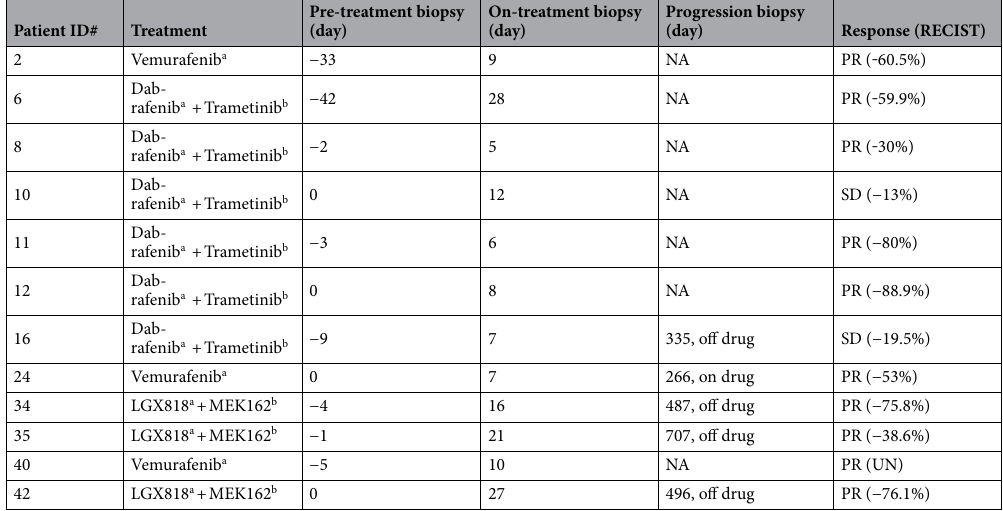
Table 1. Patient clinical informations. Biopsy day: date of biopsy-therapy start date, RECIST: best response measured radiographically, PR: partial response, SD: stable disease, UN: unknown. a BRAFi. b